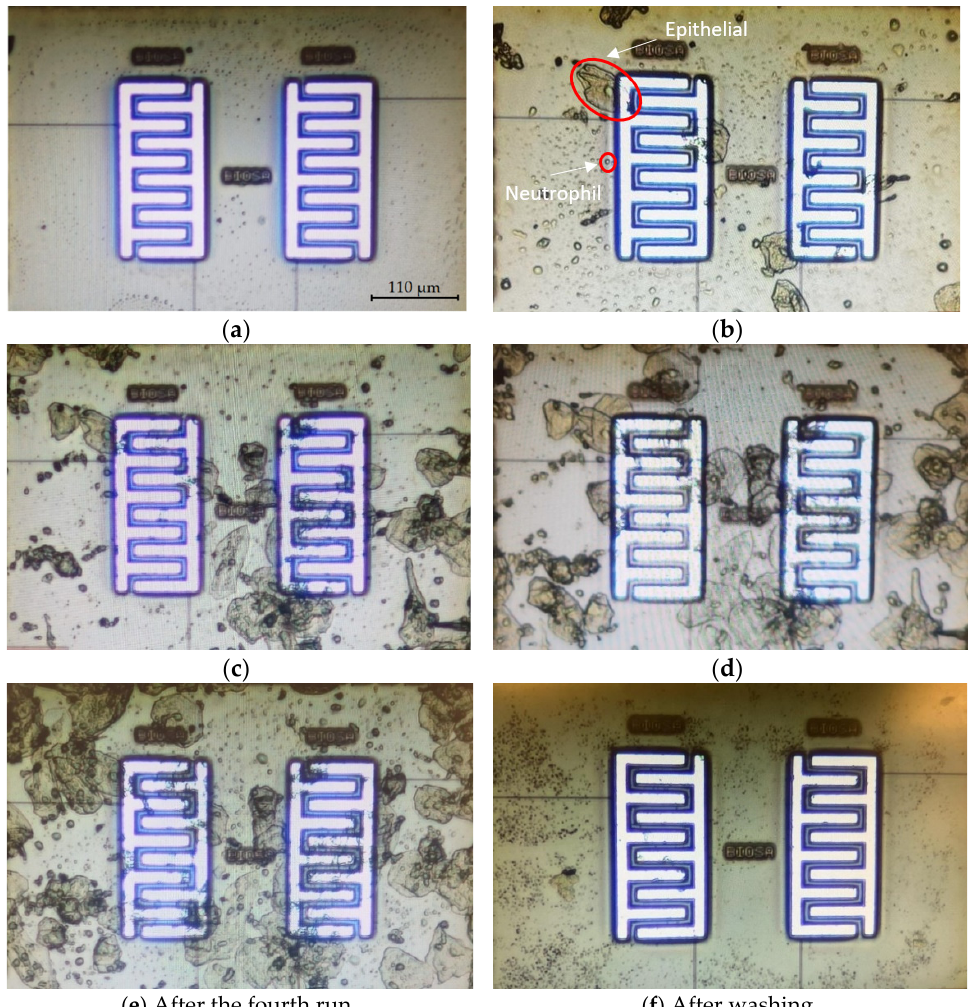
Figure 17. The microscopic image of the surface of the chip for the first experiment: ( a ) before putting samples; ( b ) after the first sample; ( c ) after the second sample; ( d ) after the third sample; ( e ) after the fourth sample; ( f ) after washing (the size of the electrodes is 220 µm × 110 µm, which shows the scale of the images).